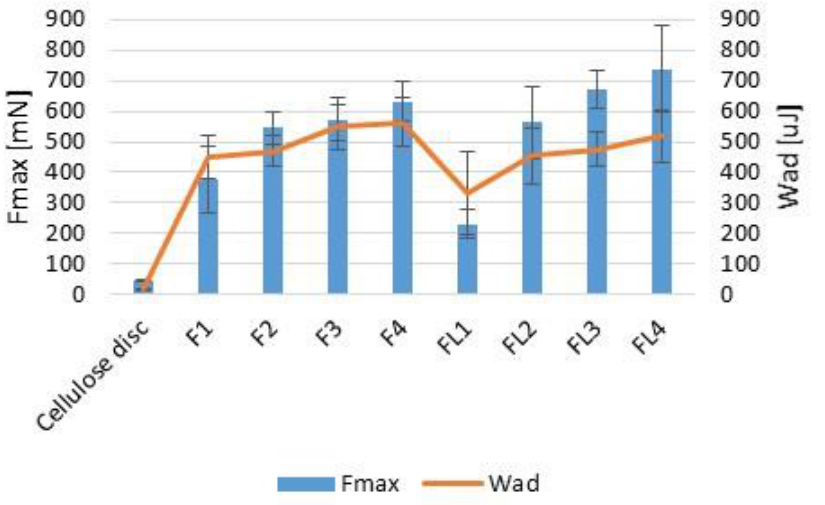
Figure 7. Mucoadhesiveness evaluated using vaginal mucosa presented as detachment force (F max ) and work of adhesion (W ad ) of placebo (F1–F4) and LUL-loaded (FL1–FL4) microparticles (mean ± SD, n = 6).